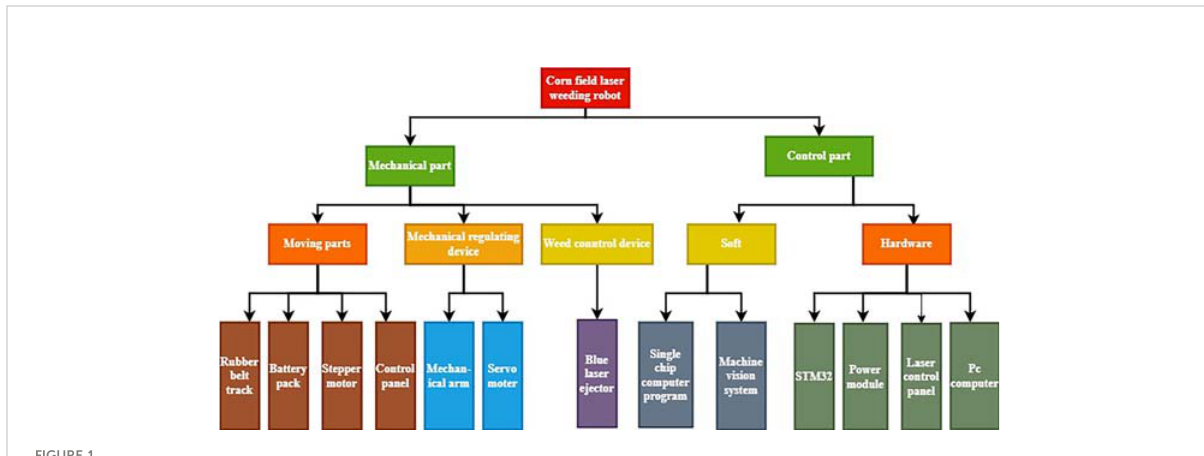
FIGURE 1 System architecture of laser weeding